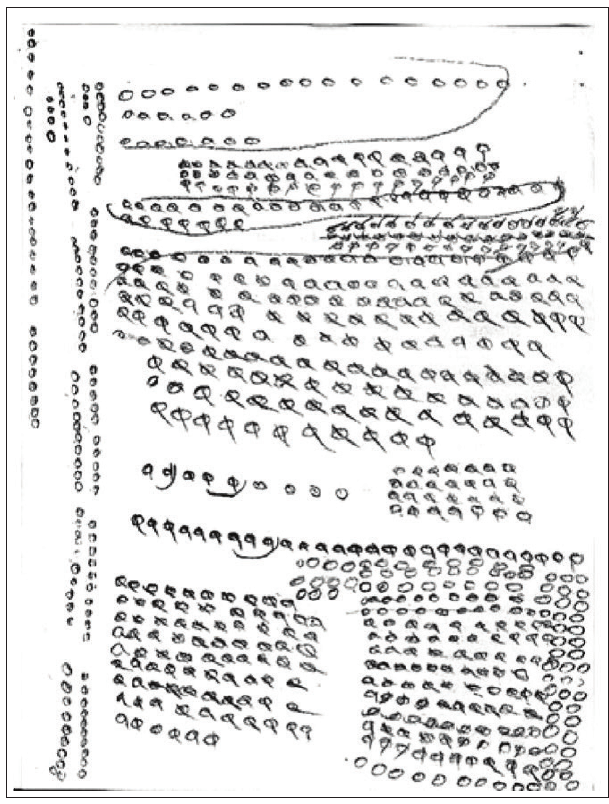
FIGURE 1: A grade 5 learner’s work on multiplication/division. more formal transformations of representations is therefore of